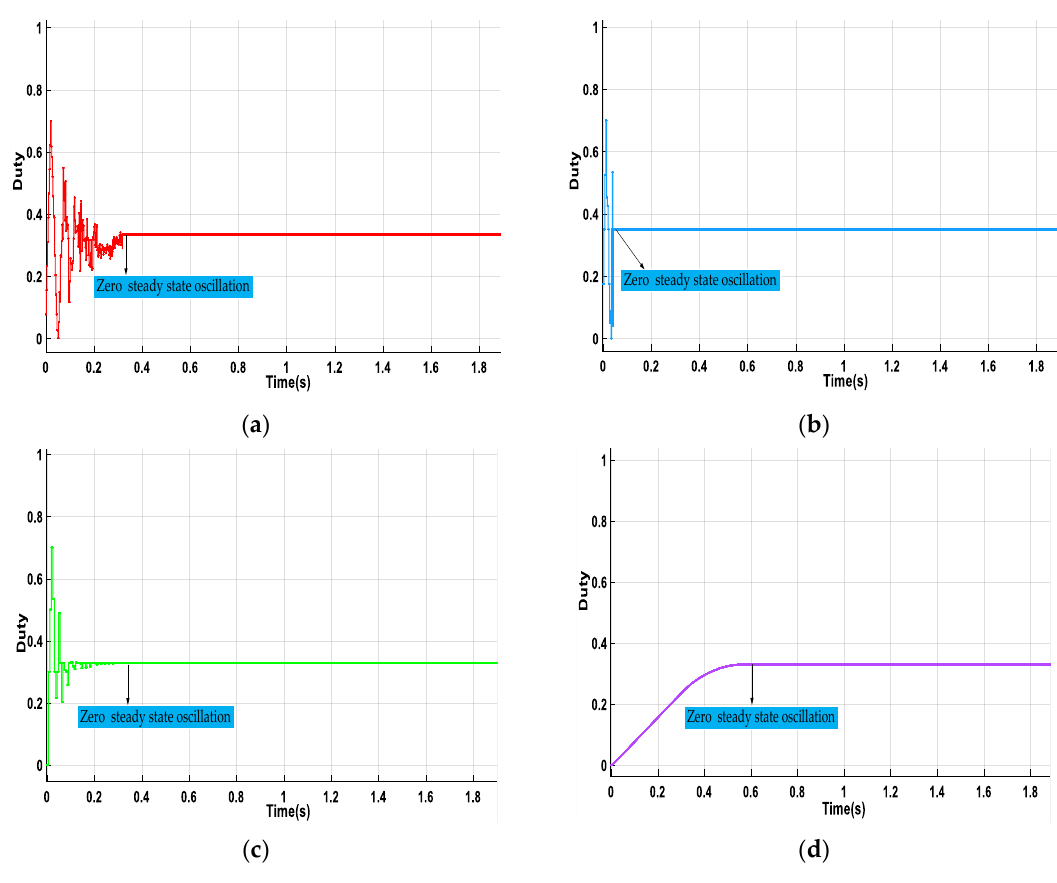
Table 8. Numerical results of TSO, ITSO-INC, CS, and INC methods in pattern 1. Parameter/Method TSO